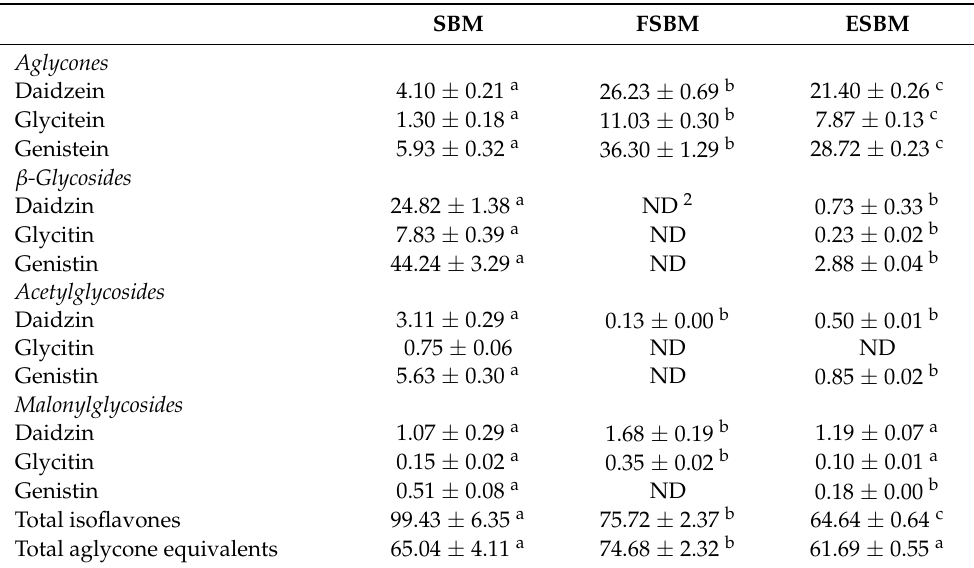
Table 4. Isoflavone profile (mg/100 g) of soybean meal (SBM), fermented soybean meal (FSBM) and enzymatically-processed soybean meal (ESBM) biscuits 1 .